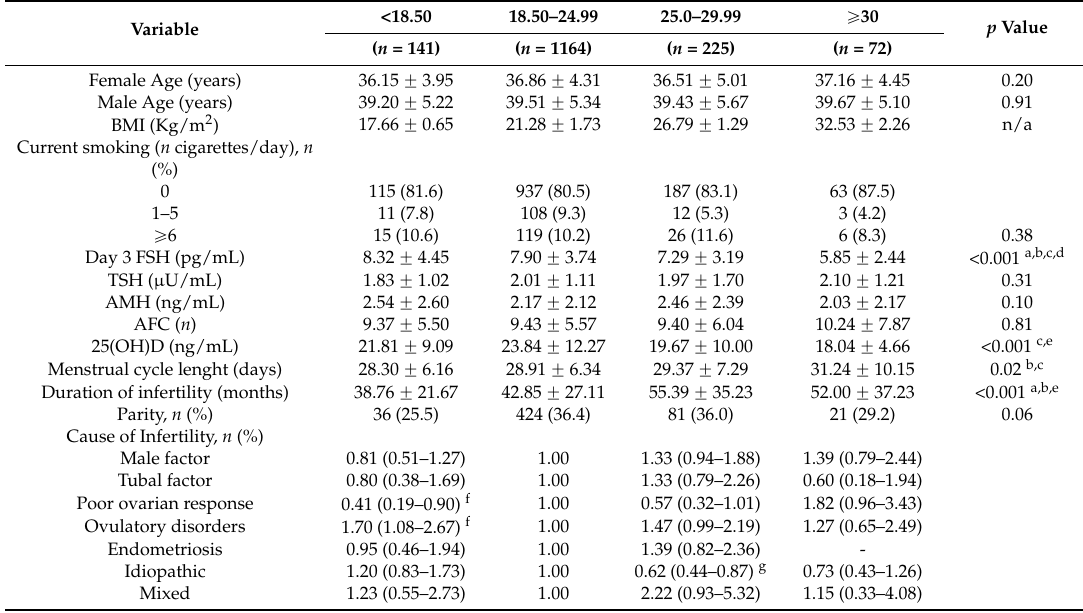
Table 1. Participant characteristics by female